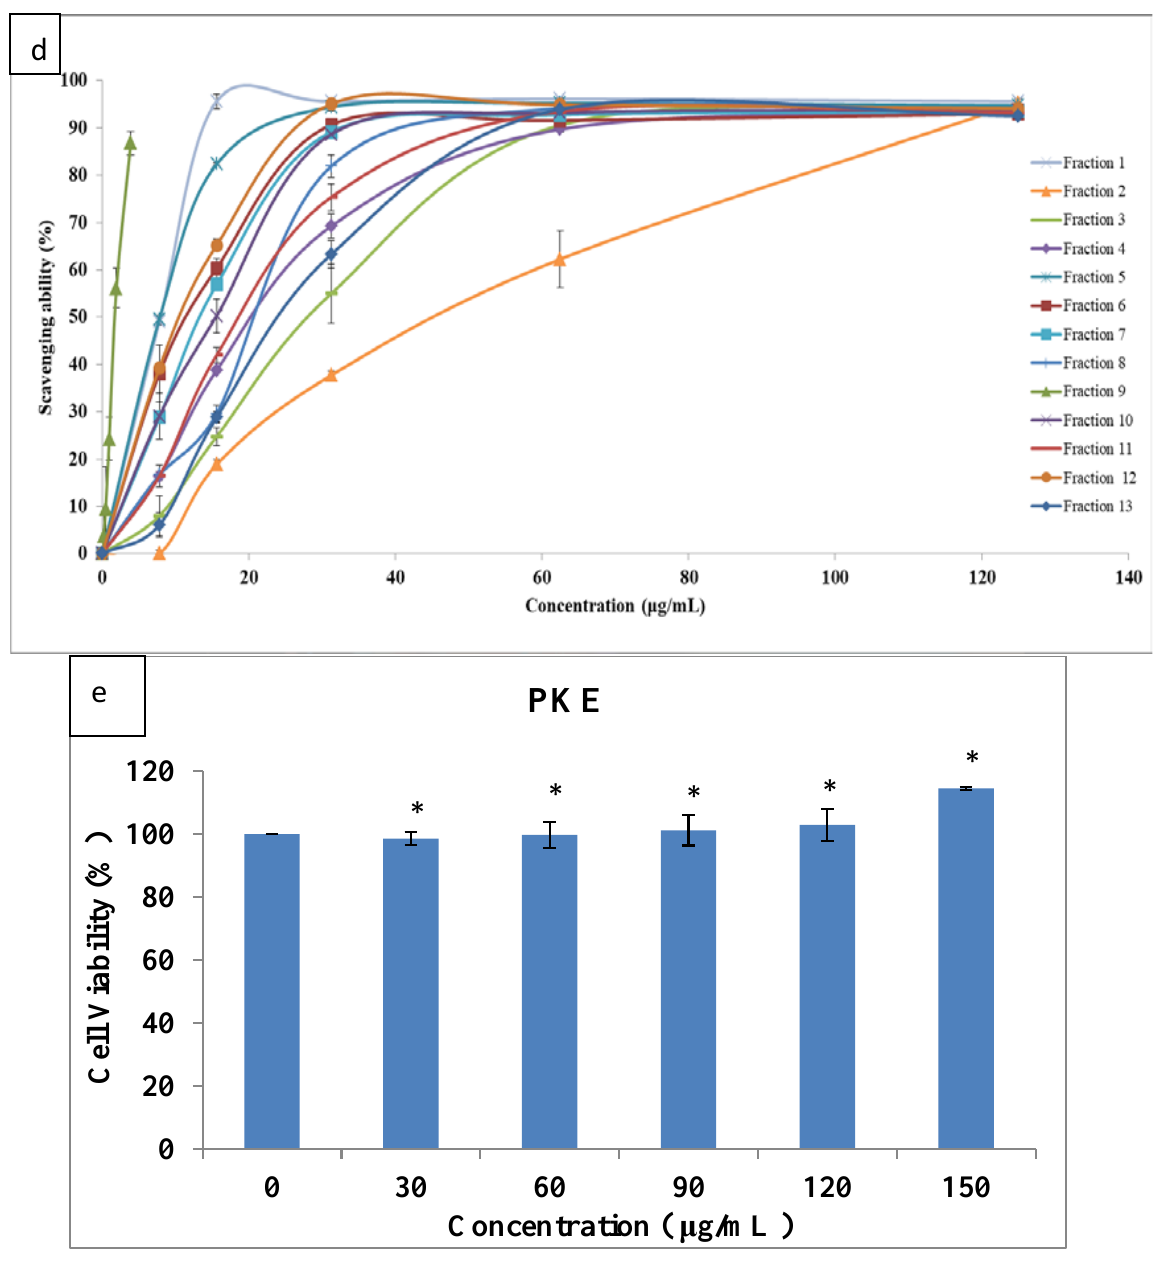
Figure 3. The cell viability for various liquid-liquid extracts and H 2 O 2 co-treatment with different concentrations ( a ), the DPPH assay treated with various liquid-liquid extracts ( b ), cell viability for various fraction extracts and H 2 O 2 co-treatment ( c ), the DPPH assay treated with extracts of various fractions ( d ), and the dose-dependent cell viability of the PKE ( e ). Values are expressed as mean ± SD ( n = 3), * p < 0.05 for compared with control group or 0